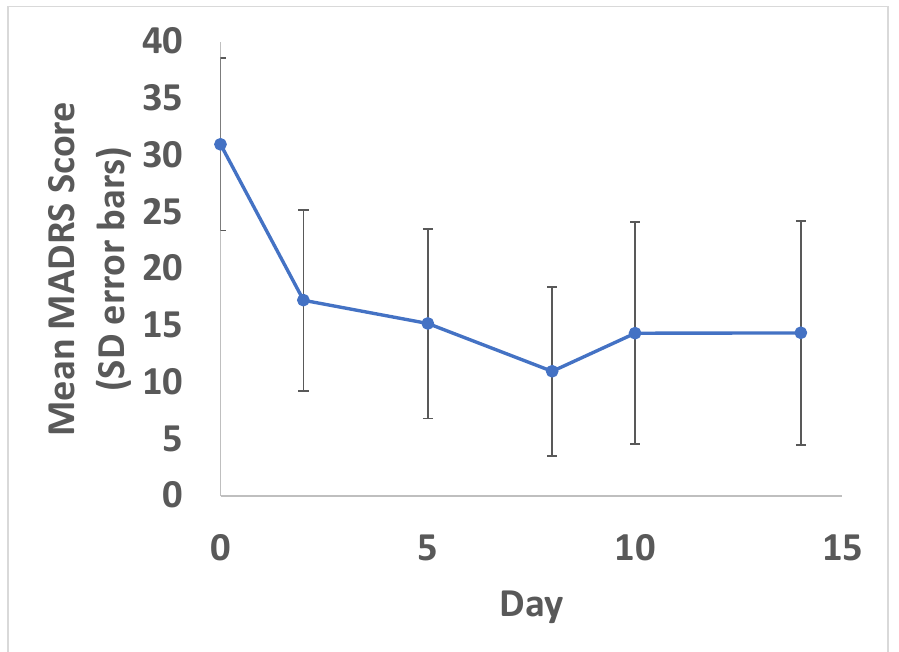
Figure 2. Change in MADRS over time. Mean MADRS scores with standard deviation (error bars) shown. A statistically significant reduction in symptoms was found at all time points compared to baseline ( p < 0.05). Ketamine doses were administered on Days 1, 4 and 7. Response and remission rates were also evaluated for MADRS on Day 8 (primary endpoint). A total of 14/20 (70%) participants met antidepressant response criteria (e.g., MADRS decreased by >50%) and 9/20 (45%) met remission criteria (MADRS < 10) by the Day 8 primary endpoint.